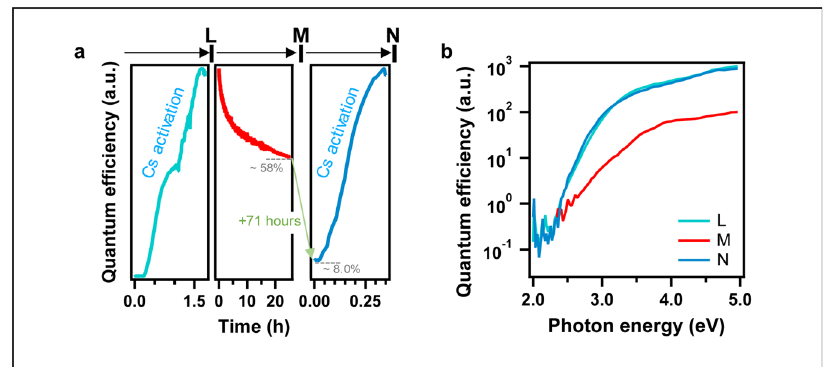
Fig. 4 Stability of the photoelectric effect. a Time evolution of the quantum ef fi ciency of the photoelectric effect in the CsPbBr3 thin fi lms measured for continuous illumination at 3.06 eV and base vacuum of 10 -9 torr. The left and right sub-plot correspond to Cs activation processes during which we expose the fi lms to the Cs source and at the same time monitor the quantum ef fi ciency (see also Supplementary Fig. 6). The central sub-plot probes monitor the ef fi ciency degradation over 25 h. The illumination was kept until 96 h when the second Cs activation was performed. b Corresponding quantum ef fi ciency spectra were taken at points L, M, and